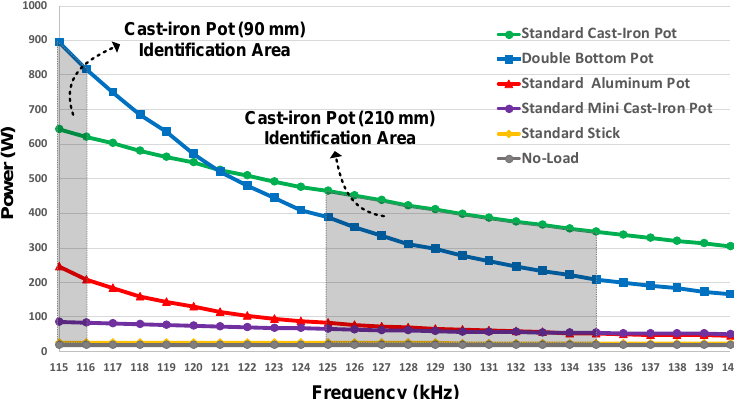
Figure 9. Power curve according to pot-type at frequencies ranging from 140 kHz to 115 kHz.